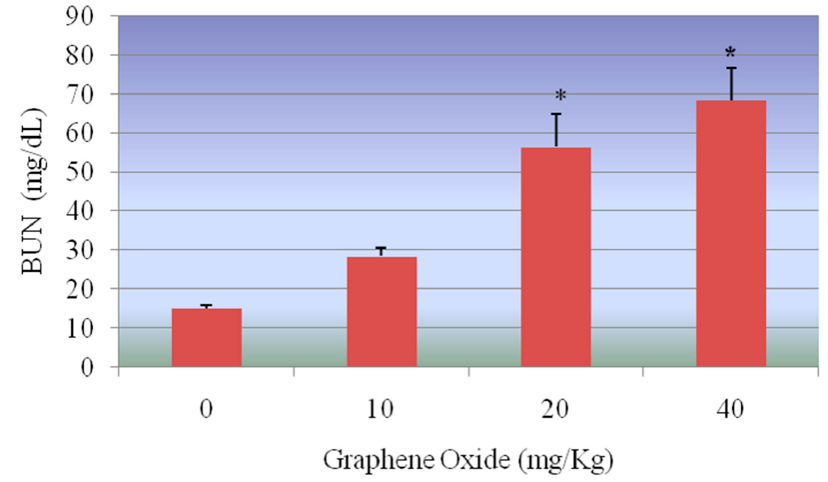
Figure 11. Effect of GOs on BUN activities in kidneys of rats after 5 days. Each bar represents mean ± SD of five rats. Values with asterisks were significantly different from control. Statistical significance ( p < 0.05) is depicted as ( * ).